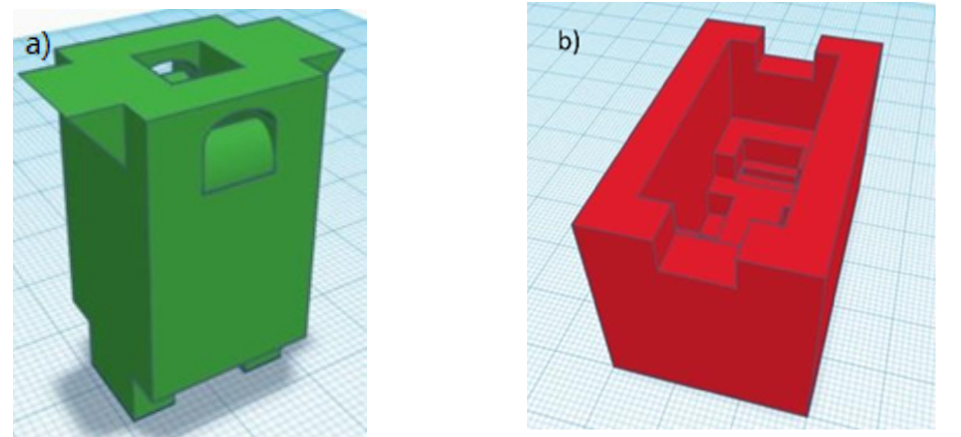
Figure 1. Design of the sensor: ( a ) measuring tank ( b ) outer shell. The ground shows millimeter graph paper.